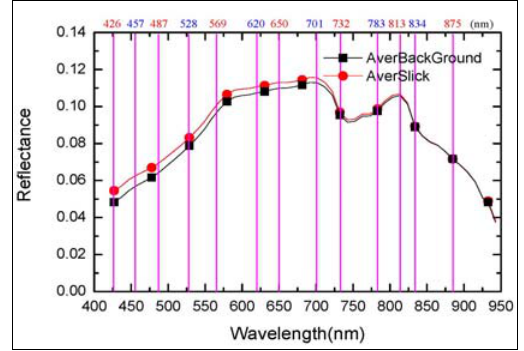
Figure 5. Reflectance of the offshore thin oil